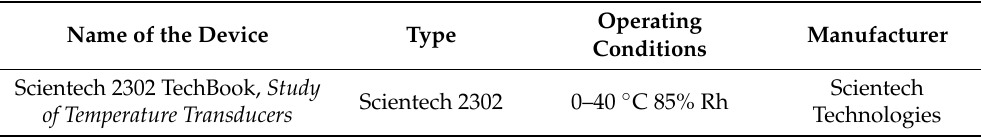
Table 1. Specifications of the measuring equipment.